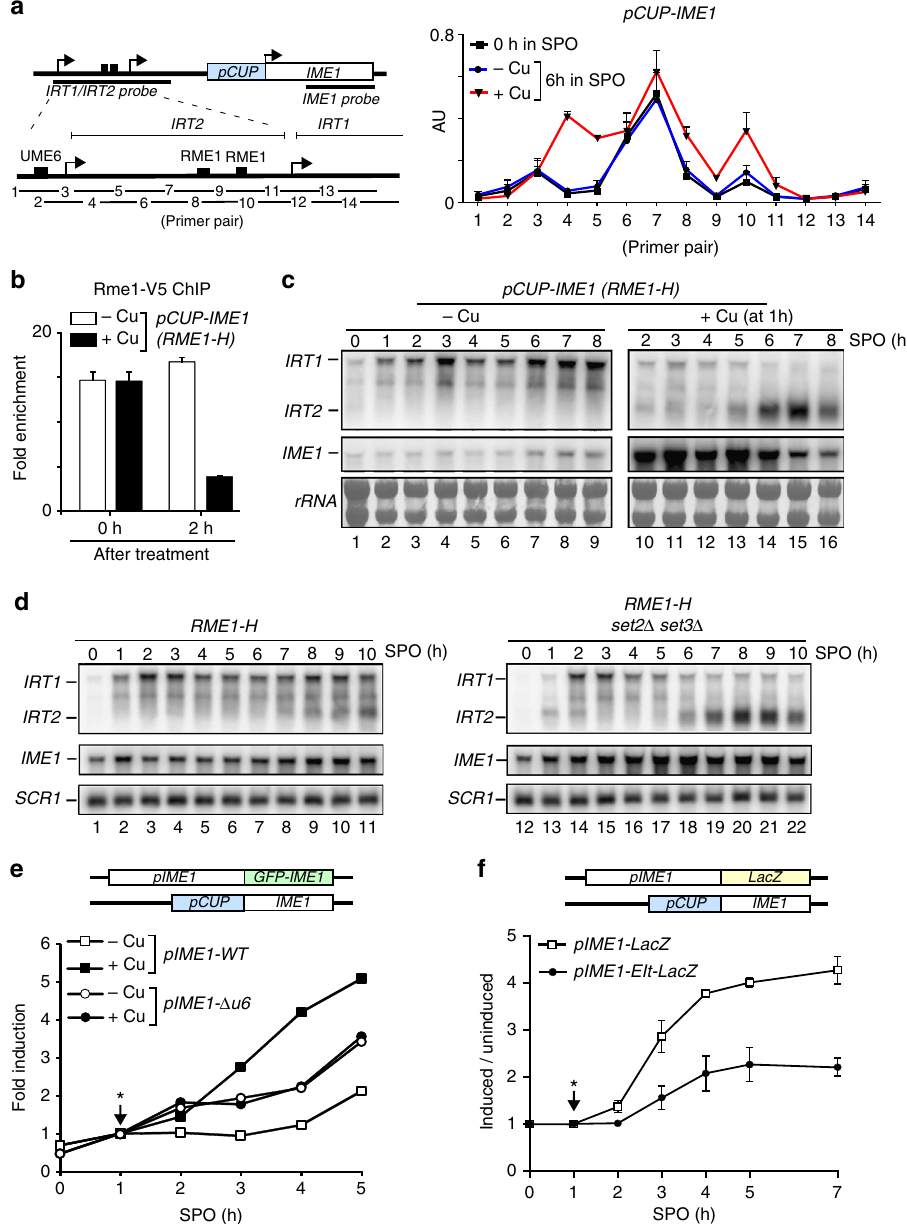
Fig. 4 Ime1 changes local chromatin via IRT2 and promotes its own expression. a Diploid cells harboring pCUP-IME1 (FW3006) were grown in rich and pre- sporulation medium before shifted to SPO, and were either not treated ( − Cu) or treated with copper sulfate ( + Cu) after 1 h in SPO. Samples were taken at 0 and 6 h in SPO. Chromatin extracts were treated with micrococcal nuclease (MNase). Mononucleosome DNA fragments were isolated and quanti fi ed using 14 primers pairs. The signals were normalized to a no MNase input. Means ± SEM of n = 3. b Diploid cells with pCUP1-IME1 and RME1-H-V5 (FW1366) were induced to enter meiosis and were either not treated ( − Cu) or treated ( + Cu) after 1 h in SPO. Samples for chromatin immunoprecipitation were taken at 0 or 2 h after induction, and quanti fi ed by qPCR. The signals were normalized to the silent mating locus ( HMR ). Means ± SEM of n = 3. c IRT1 , IRT2 , and IME1 expression in cells harboring RME1-H and pCUP-IME1 (FW2270). Cells were grown as described in a . Northern blot membranes were hybridized with probes that detects IRT1 , IRT2 , and IME1 . As a loading control, the ribosomal RNA is shown. d IRT1 , IRT2, and IME1 expression in diploid cells harboring RME1-H (FW1196) or RME1-H together with the set2 Δ set3 Δ mutant (FW1312) during entry in meiosis. Cells were grown and samples were taken as described in c . Northern blot membrane was probed for IRT1 , IRT2 , and IME1 . SCR1 expression was used as loading control. e Cells containing one copy of pCUP-IME1 , one copy of pIME1-GFP-IME1 ( pIME1 ) (FW5291), or pIME1- Δ u6-GFP-IME1 ( pIME1- Δ u6 ) (FW5295) were induced to enter meiosis in the absence ( − Cu) or presence ( + Cu) of IME1 expression. Signals were quanti fi ed ( n = 100 cells) per time point. Means ± error bars represent the 95% con fi dence interval. f Cells containing RME1-H and one copy of pCUP-IME1 , one copy of pIME1-LacZ (FW5337), or a mutant pIME1-EIt-LacZ plasmid lacking part of the IRT2 sequence including the Ume6 motif (FW5341) were induced to enter meiosis. The graph displays the ratio of β galactosidase activity signals from IME1 induced samples versus not-induced samples. Means± SEM of n = 3. *Treatment with copper